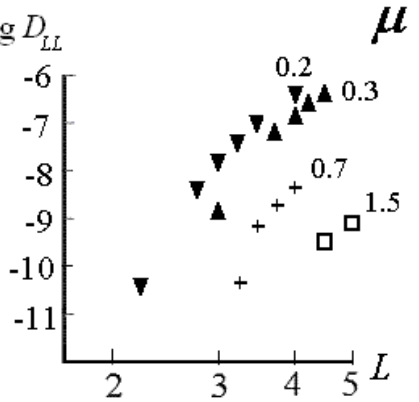
Figure 6. The results of calculations of the values of D LL (µ,L) near the equatorial plane based on the averaged Explorer-45 data in Fritz and Spjeldvik (1981) for the quiet period of 1–15 June 1972. These results take into account Figs. 2 and 4. Here D LL is given in values per second and µ is given in kiloelectronvolt per